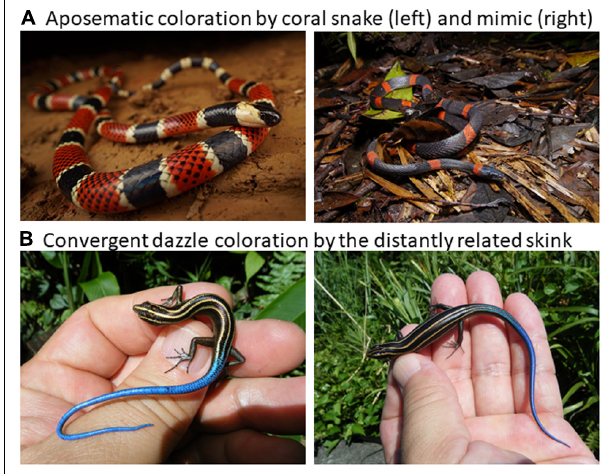
FIGURE 1 | Diverse reptile coloration. (A) An example of well known aposematic coloration by the venomous coral snake Micrurus alleni (photo by R. Fukuyama) and the non-venomous Colubrid mimic Oxyrhopus petolarius (photo by K. Fujishima). (B) An example of convergent evolution of the motile dazzle coloration of striped and blue tail of the small skinks of Emoia caeruleocauda of Micronesia (left) and Plestiodon latiscutatus of Japan